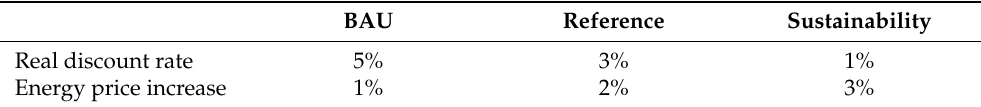
Table 1. Real discount rate and energy price increase in BAU, Reference, Sustainability scenarios. BAU Reference Sustainability Real discount